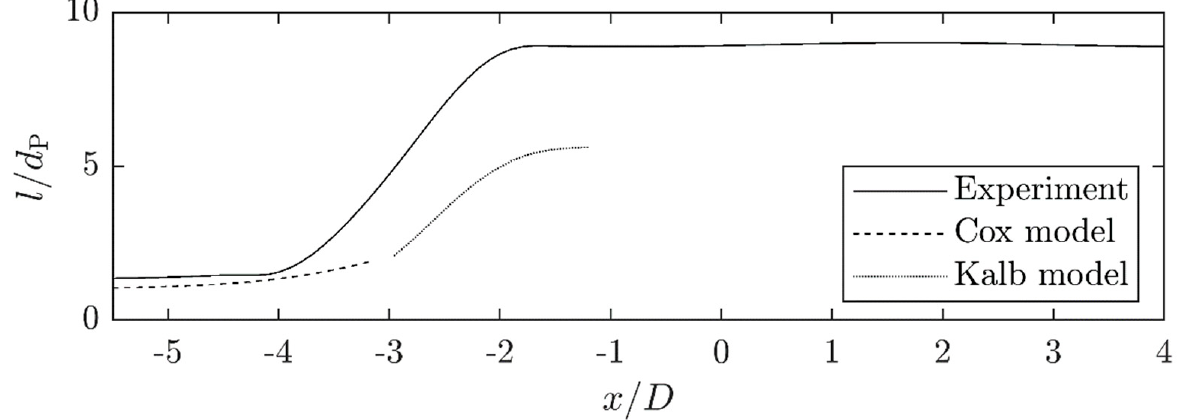
Figure 15. Comparison of the drop aspect ratio development when passing through the orifice between the experi- mental measurement and the numerical simulation according to the Cox or Kalb model for a medium viscosity drop ( λ exp = 3.0/ λ num = 3.09) at a Reynolds number of Re =